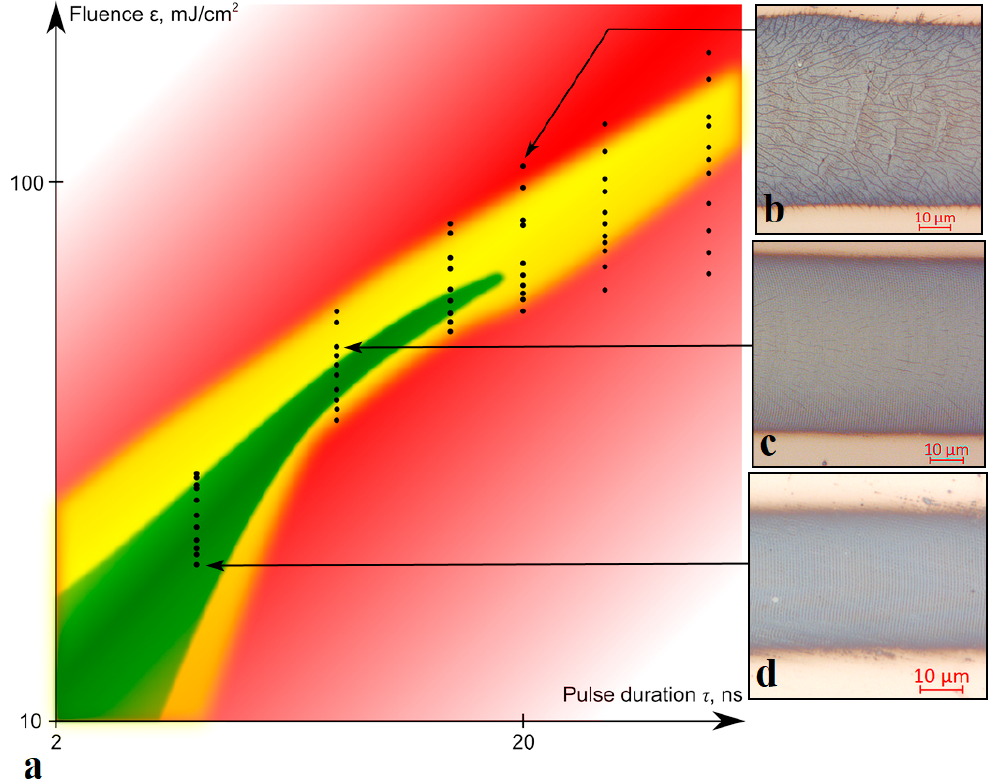
Figure 4. ( a ) Experimentally determined recording regimes for obtaining oxidative LIPSSs on titanium films of the selected thickness: the green area is homogeneous, with contrast structures over the entire track area; the yellow area has structures predominantly along the edges of the tracks; the red area has no structures or film cracking over the entire track area. Black dots mark the experimentally obtained results. Recording regimes (with the corresponding points marked in ( a )): ( b ) τ = 20 ns, P av = 100 mW, f = 15 kHz, ε = 100 mJ/cm 2 ; ( c ) τ = 8 ns, P av = 100 mW, f = 30 kHz, ε = 48 mJ / cm 2 ; ( d ) τ = 4 ns, P av = 100 mW, f = 60 kHz, ε = 23 mJ / cm 2 .